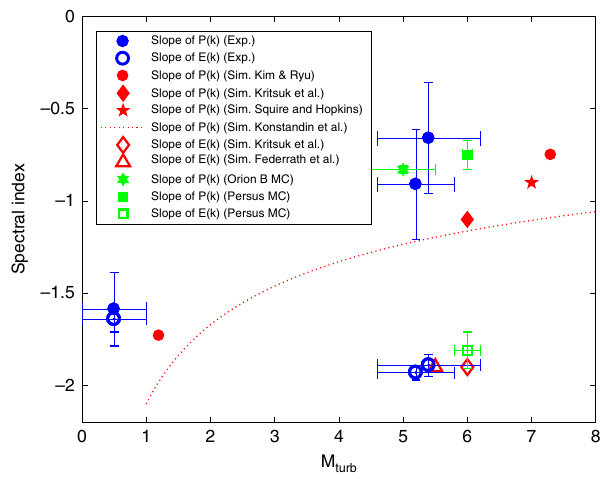
Fig. 4 Spectral index of density and velocity turbulence. The scaling exponent of the density power spectrum, P ( k ) (solid markers), and the velocity power spectrum, E ( k ) (open markers) is plotted against the turbulent Mach number. The results from this experiment are plotted in blue, and correspond to the times t = 500, 600, and 700 ns. Shown in red are hydrodynamic results from Kim & Ryu 18 (circles), Kritsuk et al. 8 (diamonds), Squire and Hopkins 32 (star), Konstandin et al. 33 (dotted line), and Federrath et al. 30 (triangle). In green are astrophysical observations of the scaling exponent of the density power spectrum of the Orion B MC 15 (star), the density power spectrum of the Perseus MC 16,17 (square), and the velocity power spectrum of the Perseus MC 29 (square). The Mach number error bar is a consequence of uncertainties in the measurement of the thermodynamic conditions of the plasma (see Fig. 2). The error bars for the density spectral index show the variation across the four regions of the plasma highlighted in Fig. 2b, and the error bars in the velocity spectral index were found by shifting the Fourier transform window by 20 ns in either